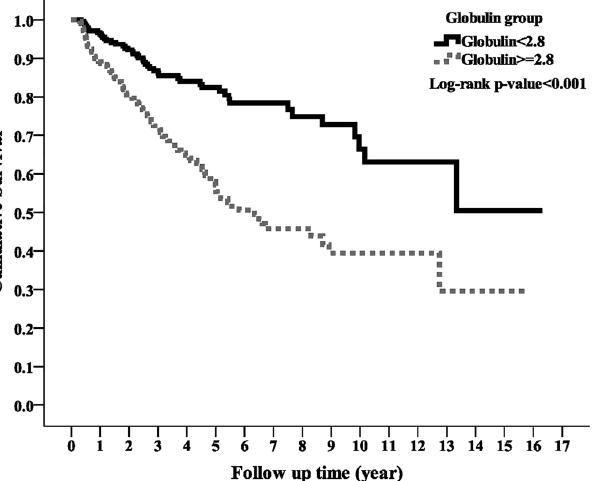
Figure 1. Kaplan–Meier curve of overall patient survival according to the globulin groups (log-rank test, p <